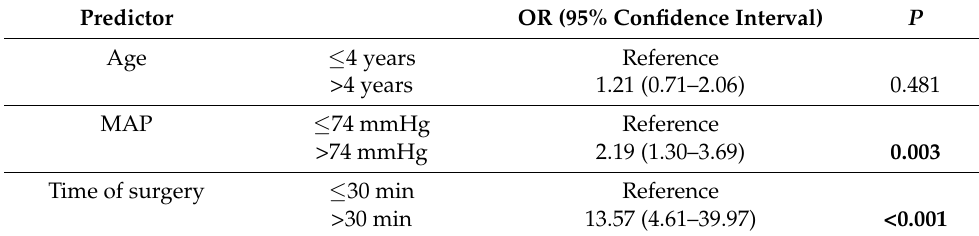
Table 4. Multidimensional logistic regression